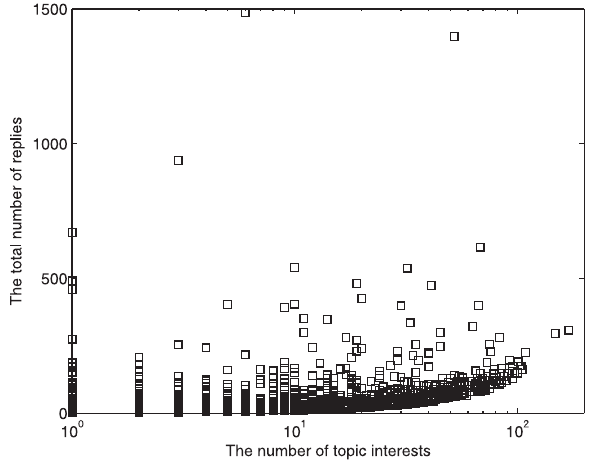
Figure 3. Total number of replies for each user as a function of the number of user’s topic interest. Some users that are